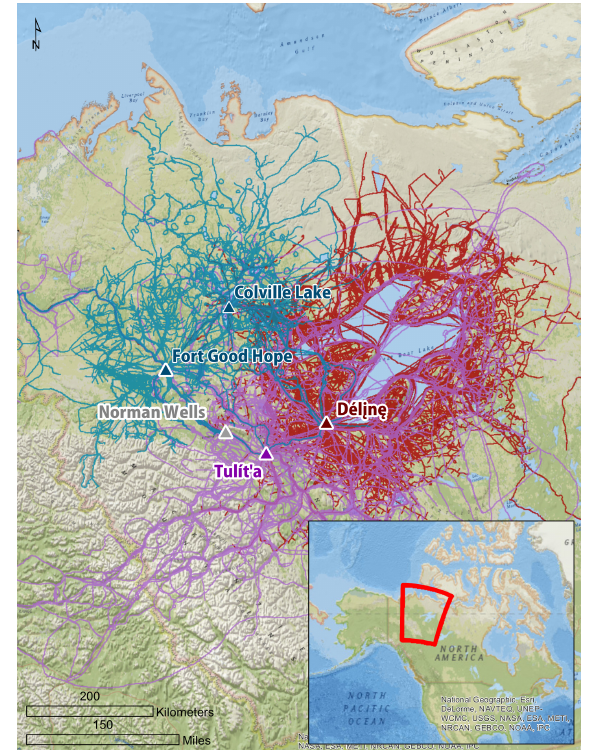
Fig. 1 . The Sahtú region of the Northwest Territories,